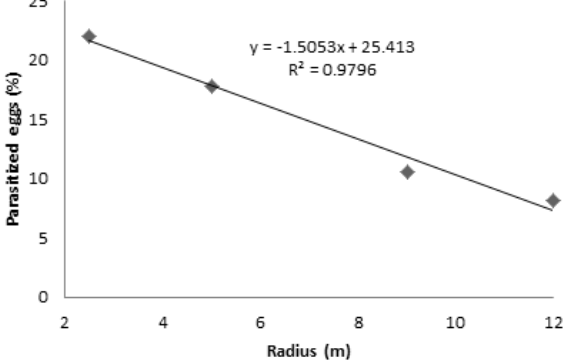
Figure 1. Scattering radius of Trichogramma pretiosum (Hymenoptera: Trichogrammatidae) and parasitism on eggs of the alternative host Anagasta kuehniella (Lepidoptera: Pyralidae) in maize V4 stage (F= 96.44 and P=